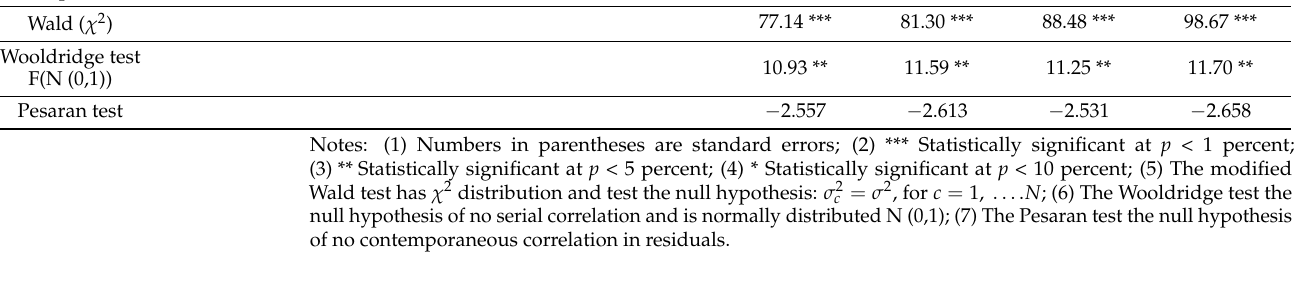
Table 2. Fixed effects estimation results for solar PV on the commercial